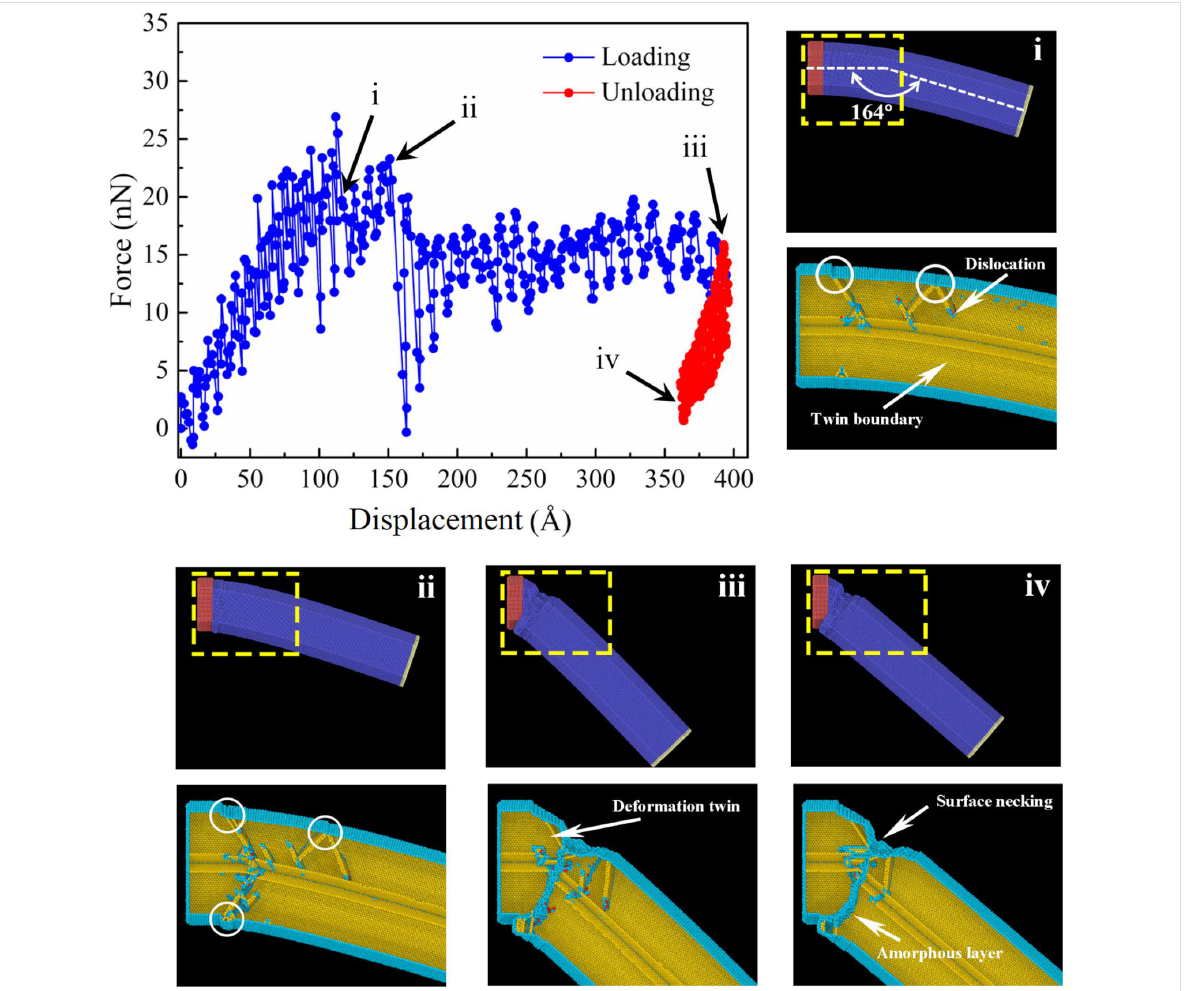
Figure 8: Bending force versus displacement curve (top) and the evolution of the atomic structure and the internal defects during bending of the NW (bottom). In the local cross-section of the NW, atoms in a perfect lattice are not shown for clarity.